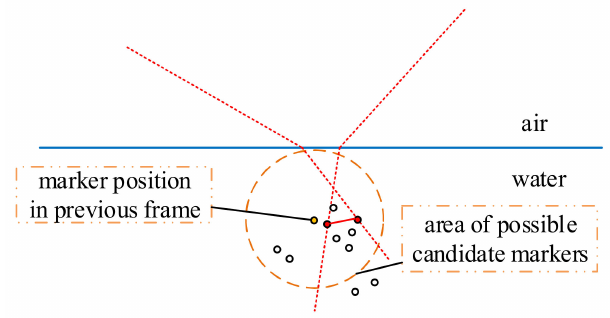
Figure 4. Marker forecast.